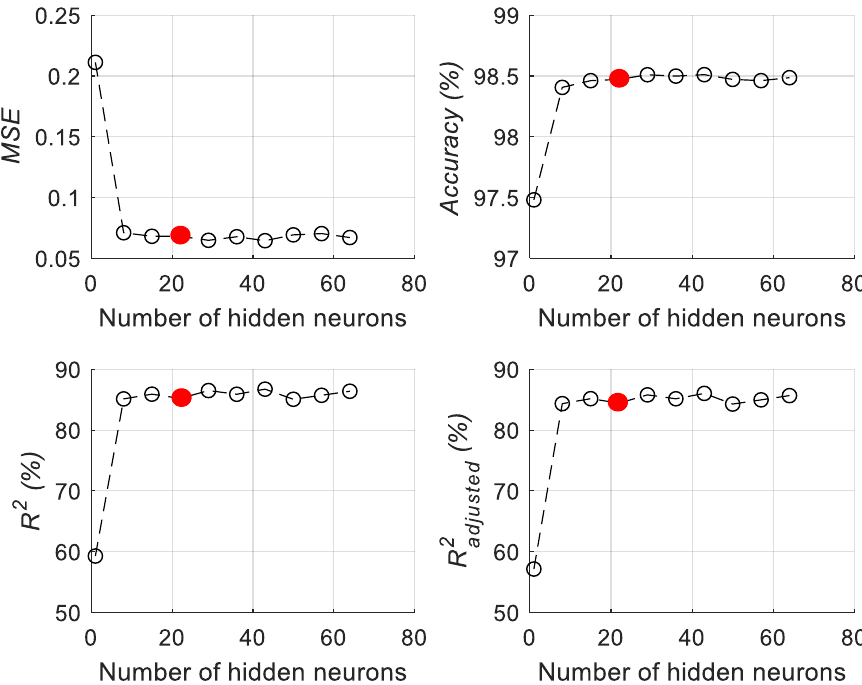
Figure 4. The influence of the number of hidden neurons on the prediction performance of the ANN